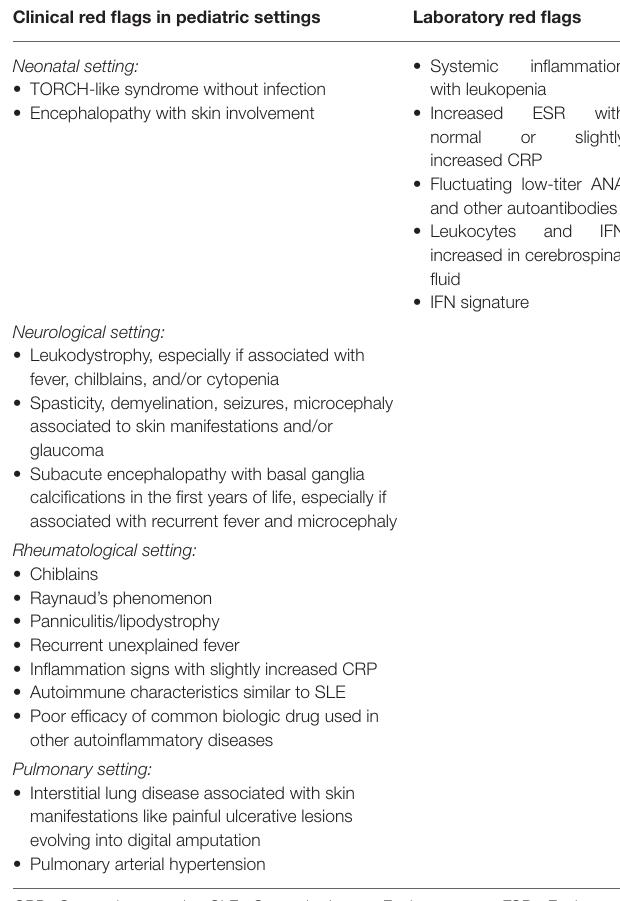
TABLE 3 | Red flags of